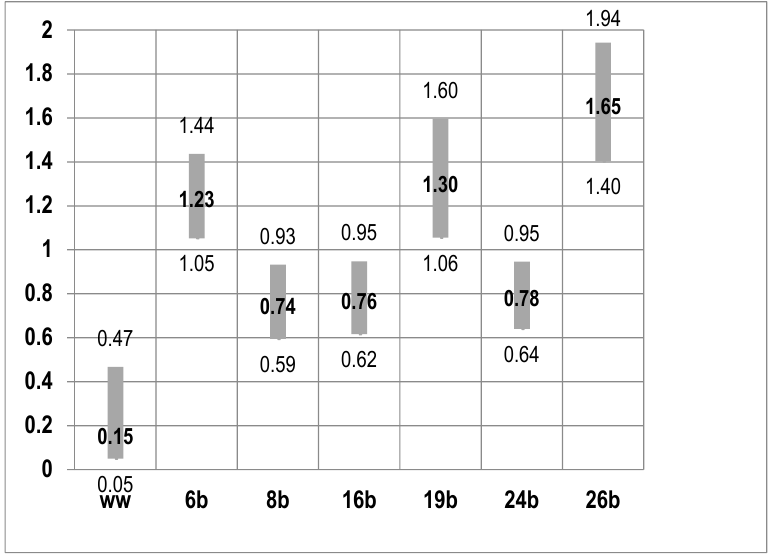
Figure 2. Factors determining weight loss: logistic regression based on the odds ratio +95%Cl;